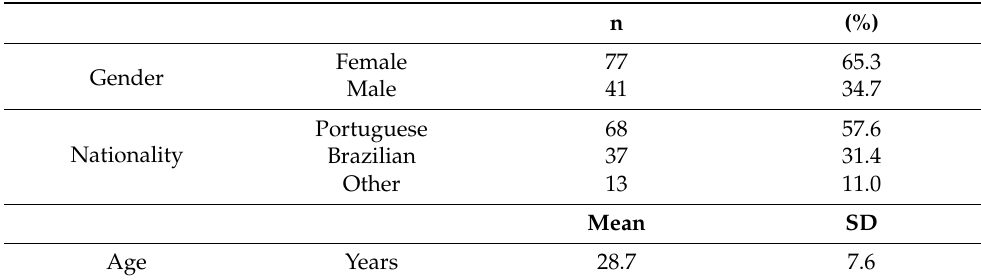
Table 2. Sociodemographic characteristics of the participants in the study (n = 118).